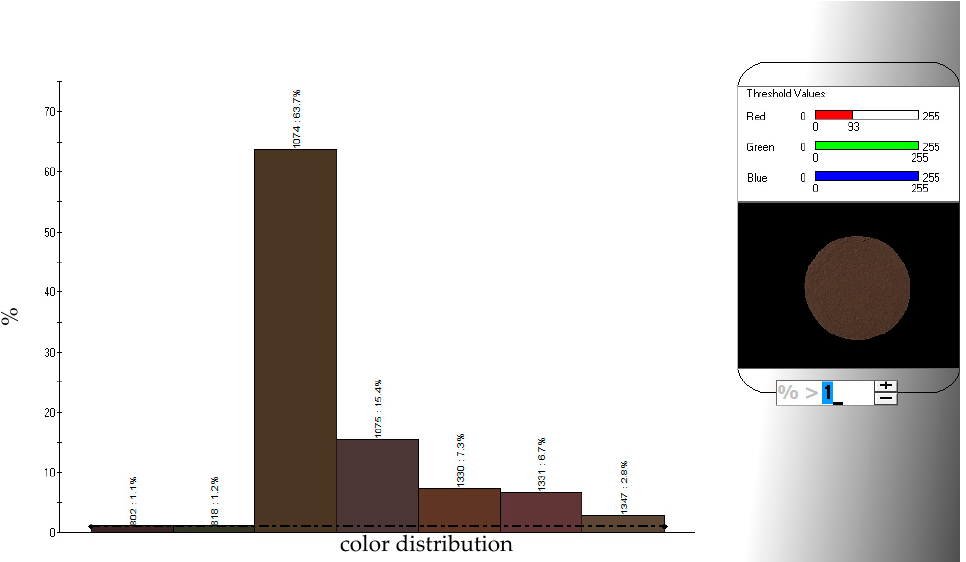
Figure 4. Detailed colour analysis of black garlic from conventional cultivation (BG) using the instrumental method (“electronic eye”).